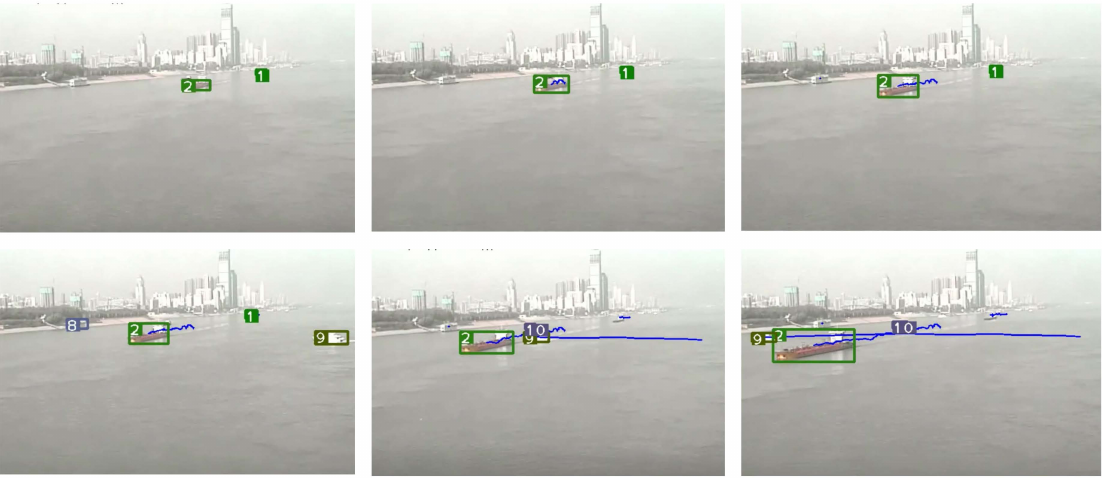
Figure 18. Vessel tracking